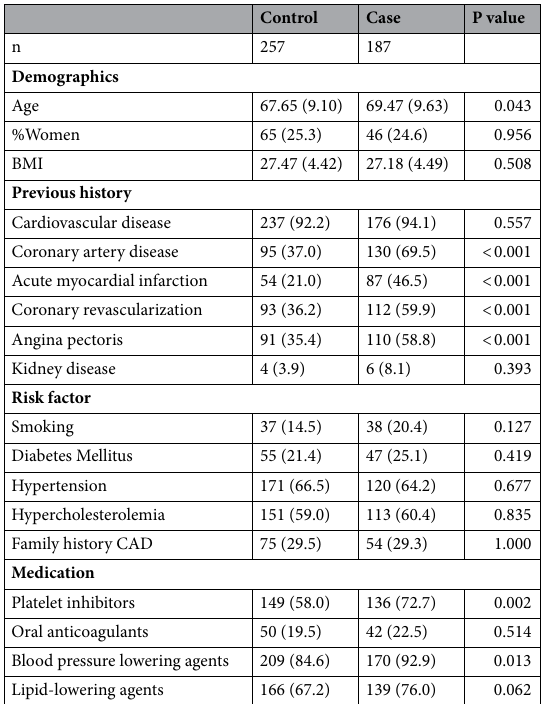
Table 1. Baseline characteristics. Values are displayed as mean ± SD or frequency (%), Case = patient with a SDS score ≥ 2 on myocardial perfusion imaging (MPI), and/or functionally relevant coronary artery disease on coronary angiogram. CAD Coronary artery disease. CVD history of CAD or peripheral vascular disease or history of ischemia CVA, Kidney disease = eGFR <